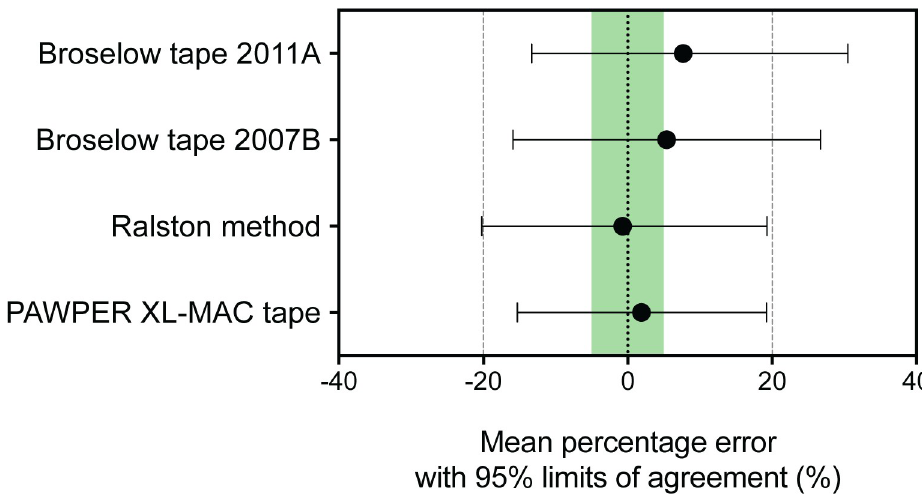
Fig 3. Analyses of the bias and precision of the weight estimation systems. The forest plot shows the overall bias (the black circles indicate the mean percentage error), as well as the precision (the whiskers indicate the Bland & Altman 95% limits of agreement) for each system. The green shaded area denotes an acceptable MPE (within ± 5%), while the dashed lines indicate an acceptable range for the 95% LOA (within ± 20%). The paired t-test was significant at the p < 0.001 level for every comparison of MPE and RMSPE. The MPE of the PAWPER XL-MAC and Ralston methods were clinically superior to the Broselow tape methods. The precision (quantified using the RMSPE) of the PAWPER XL-MAC method was clinically superior to all other